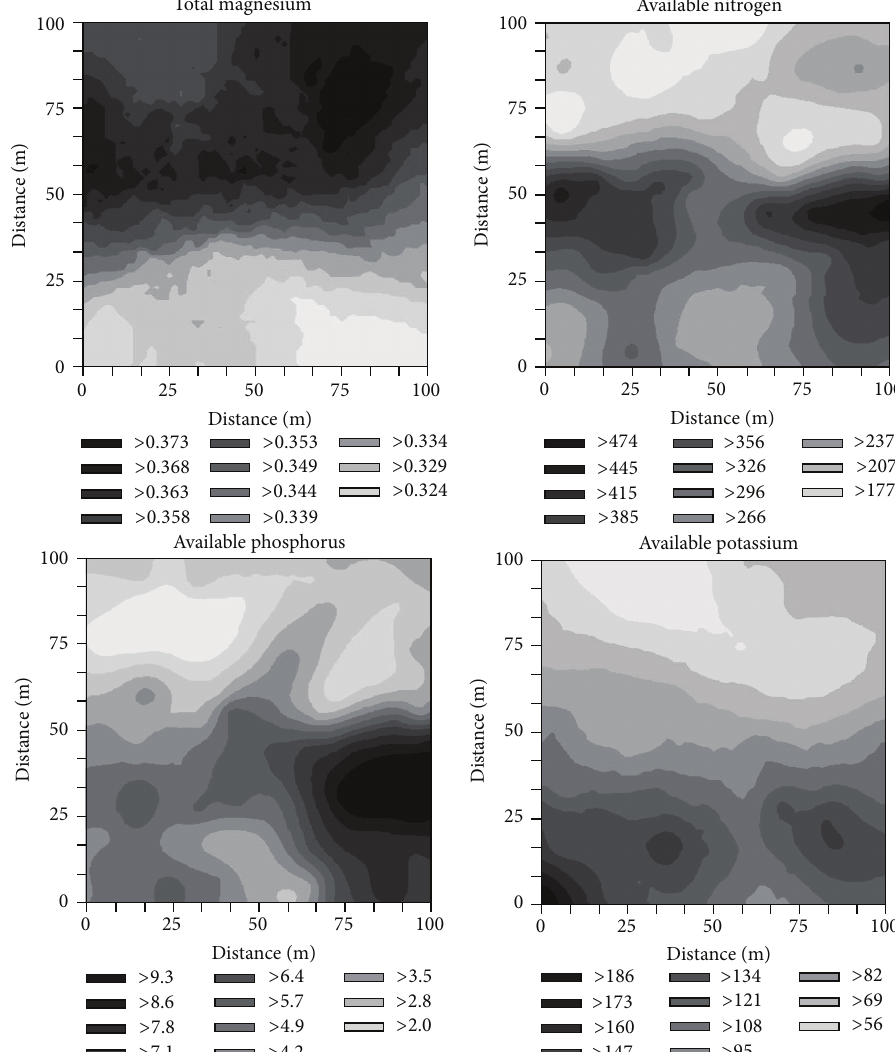
Figure 3: Distribution of the soil chemical properties of the entire study plot using kriging interpolation.